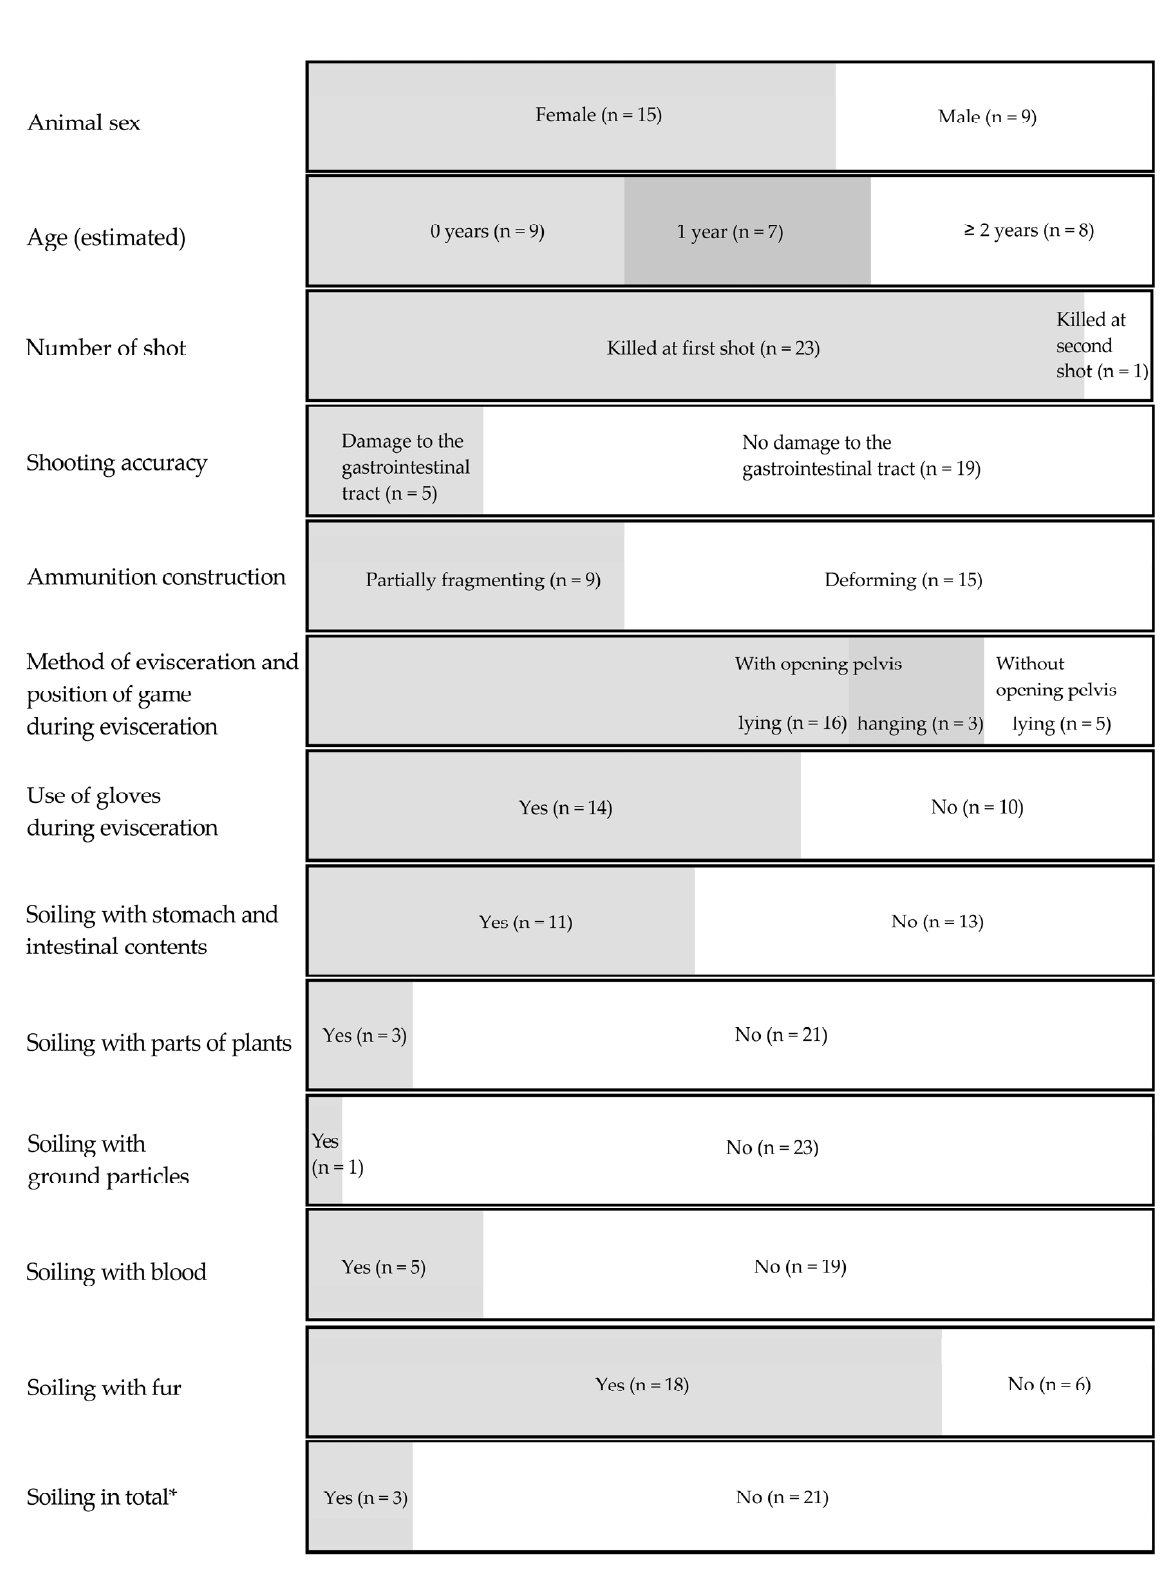
Figure 2. Animal-related parameters and parameters representing shooting-related factors, handling of roe deer carcasses as well as visual evaluation of the body cavity. * Soiling in total was classified as “no” if no visible contamination was present in the body cavity and “yes” if one or more types of contamination were present in the body cavity.